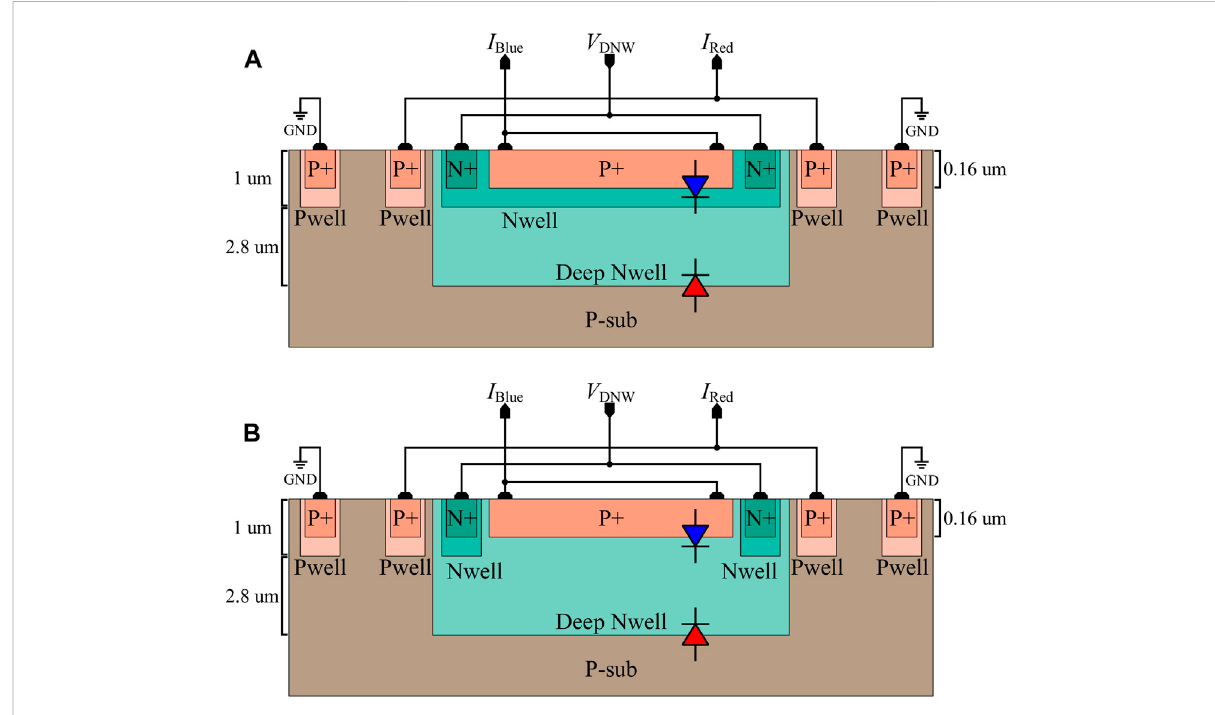
FIGURE 2 The cross section of the VDJ-PD. (A) Pimp/Nwell/Deep Nwell/Psub; (B) Pimp/Deep Nwell/Psub.